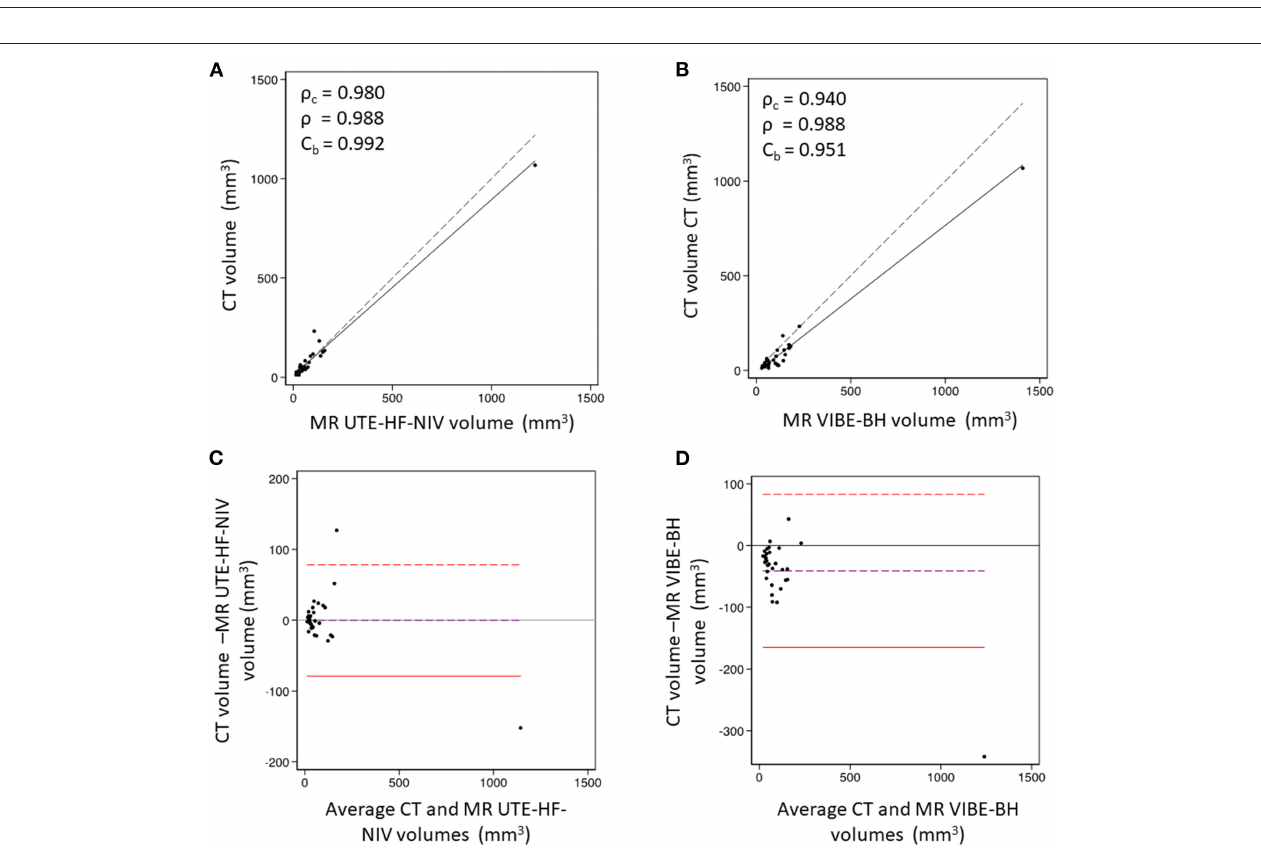
FIGURE 4 | Nodule volume measurement comparison between CT (soft kernel) and MR images. (A) Lin’s concordance analysis between CT and UTE-HFNIV. The graph shows an excellent concordance that corresponds to an overestimation of 13.2% of nodule volumes by UTE-HF-NIV compared to CT soft kernel. (B) Lin’s concordance analysis between CT and VIBE-BH. VIBE-BH overestimated the lung nodule volume by 28.8%, with a significantly lower concordance as compared to UTE-HF-NIV ( p < 0.05). Dashed line is the line of equality. (C) Bland-Altman plot comparing CT soft kernel and UTE-HF-NIV MRI based volume nodule measurements. A bias of − 0.16 mm 3 was observed (limits of agreements − 79 to 78 mm 3 ). (D) Bland-Altman plot comparing CT soft kernel and VIBE-BH MRI based volume nodule measurements. A bias of − 41 mm 3 was observed, with limits of agreements ( − 165 to 83 mm 3 ). These were based on a random selection of nodules when the number of nodules per patient exceeded 5. Dashed purple line is the observed average agreement. Dashed red lines are the 95% limits of agreement.